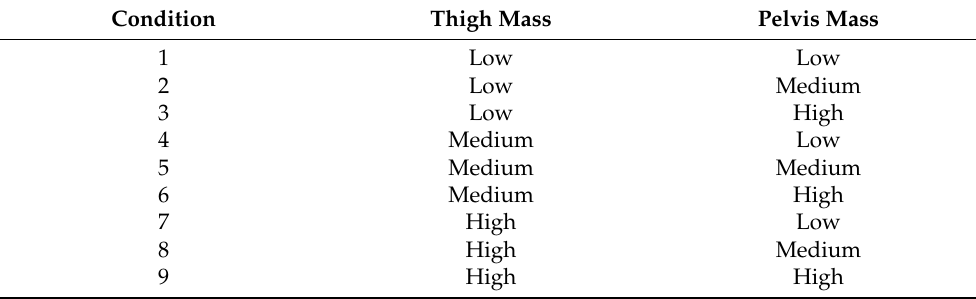
Figure 1. Experimental setup consisting of tungsten mass, mass holders, surface EMG sensors and retroreflective motion capture markers. Markers were placed symmetrically on the iliac crest, posterior superior iliac spine, anterior superior iliac spine, femur lateral epicondyle, femur medial epicondyle, fibula apex of lateral malleolus, tibia apex of medial malleolus, posterior surface of calcaneus, head of second metatarsal bone, head of first metatarsal bone, head of fifth metatarsal bone and acromion. A marker was also placed on the 7th cervical vertebrae and the sternum jugular notch. Additional tracking markers were placed on leg segments, with two on each thigh and one on each shank. Table 1. The 9 loaded conditions represented full-factorial combinations of bilateral added mass at the thighs and the pelvis. The combinations consisted of a low (+3.6 lb/+1.6 kg), medium (+7.2 lb/+3.3 kg) and high (+10.8 lb/+4.9 kg) mass amounts at each